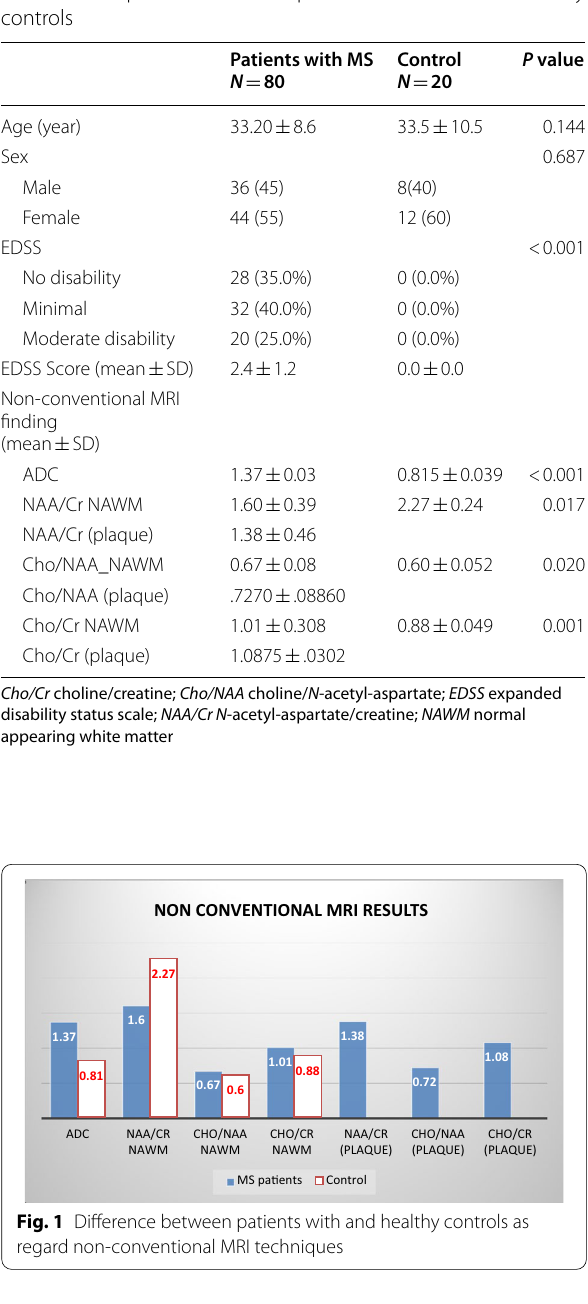
nificant difference between disability group 1, 2 and 3 in comparing the mean of metabolic changes, namely; NAA/Cr, Cho/NAA, Cho/Cr of NAWM and the Cho/ NAA and Cho/Cr at the plaque (Table 3). There was a significant correlation between ADC and disability ( r 0.42 and P value < 0.001) (Table 4). =